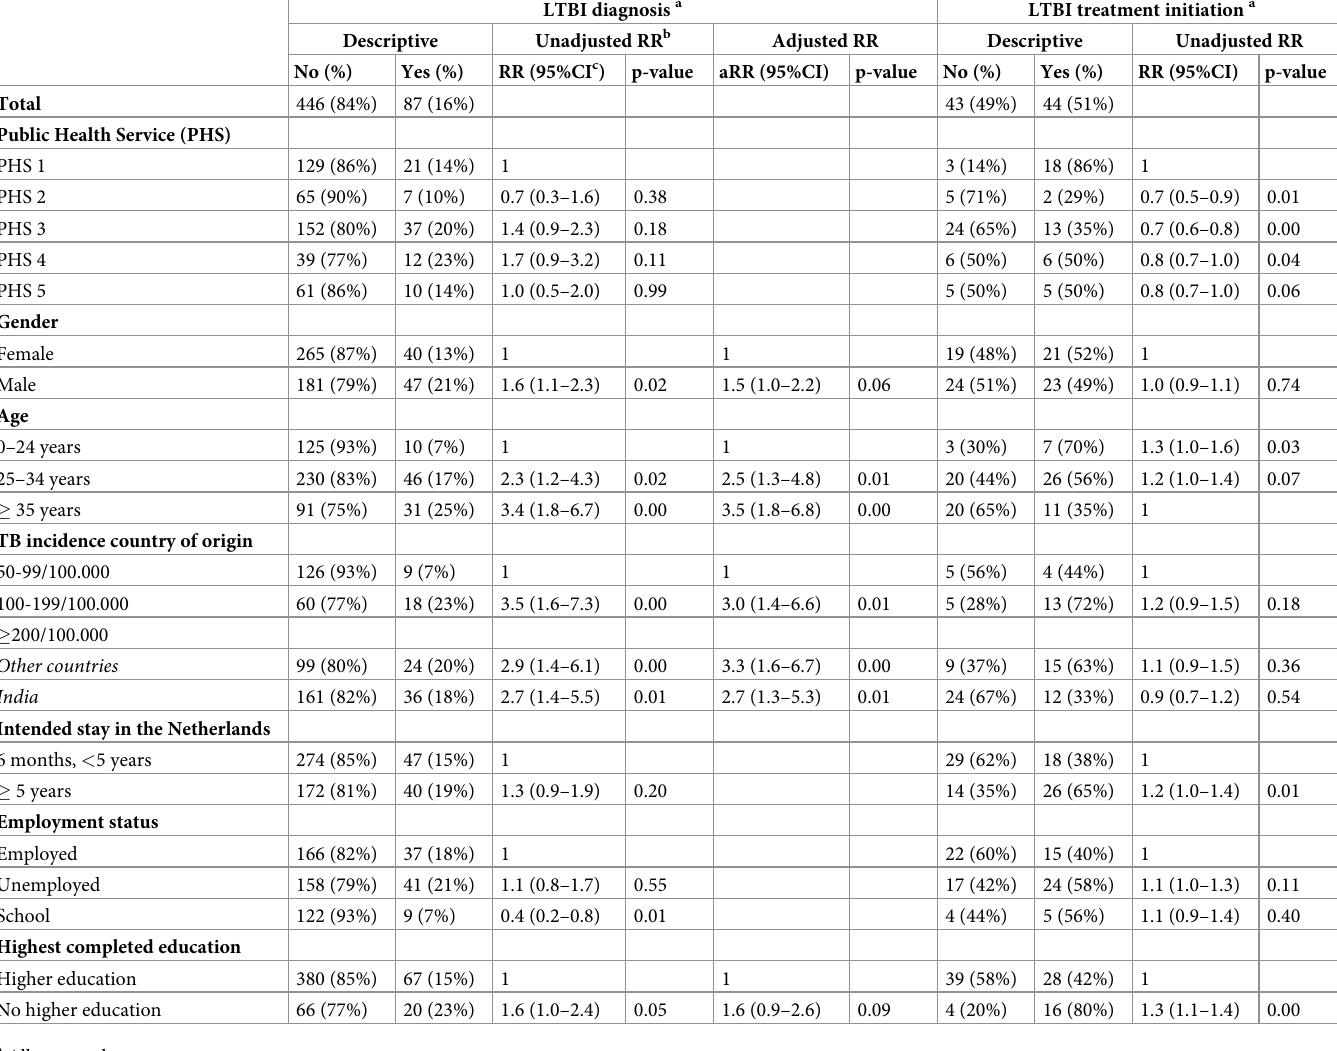
Table 2. Results of Poisson regression model with robust variance